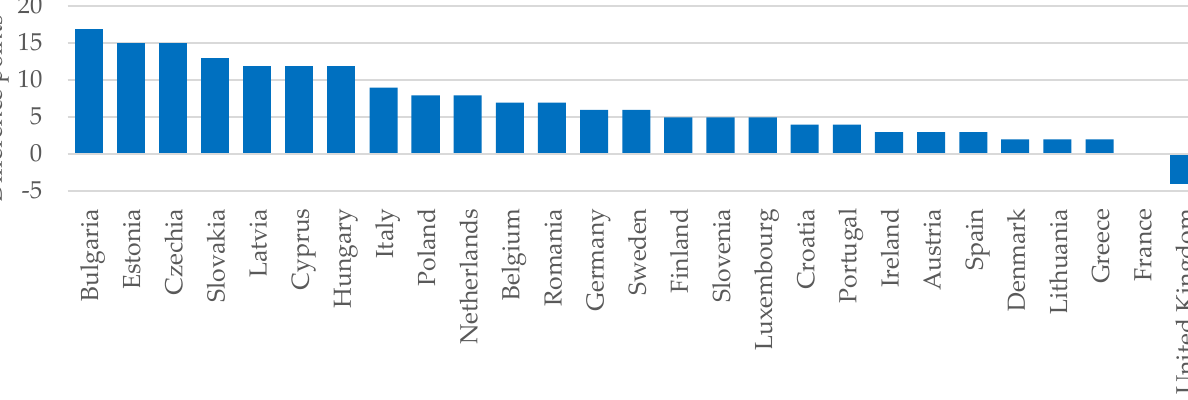
Figure 3. Overall changes in country scores in 2019 compared to 2014. Source: authors’ computation .